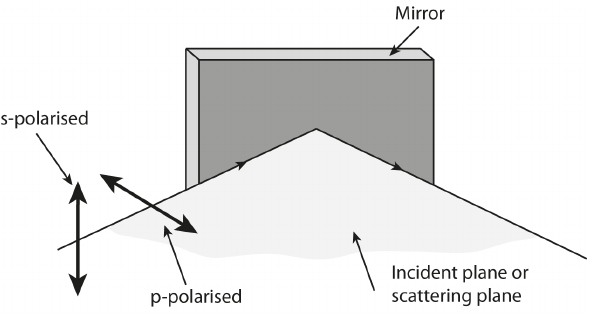
Figure 2. s and p polarisation direction definitions for a